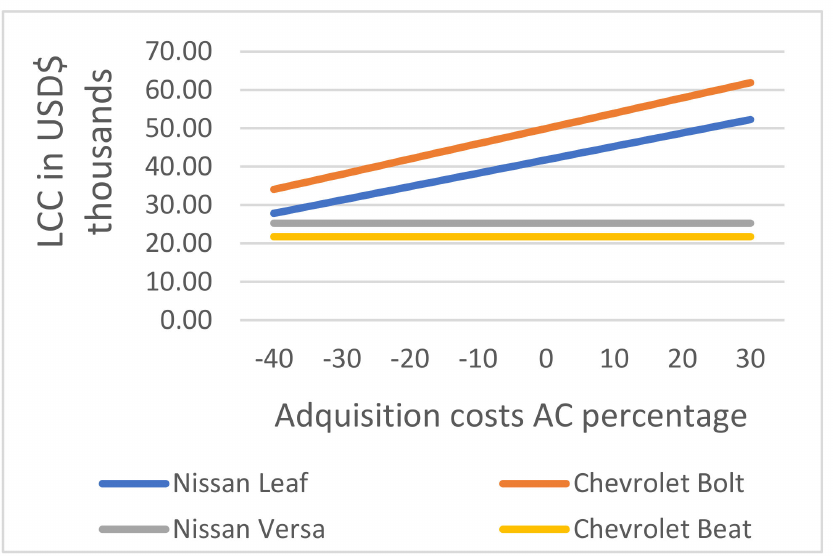
Figure 4. Acquisition cost percentage